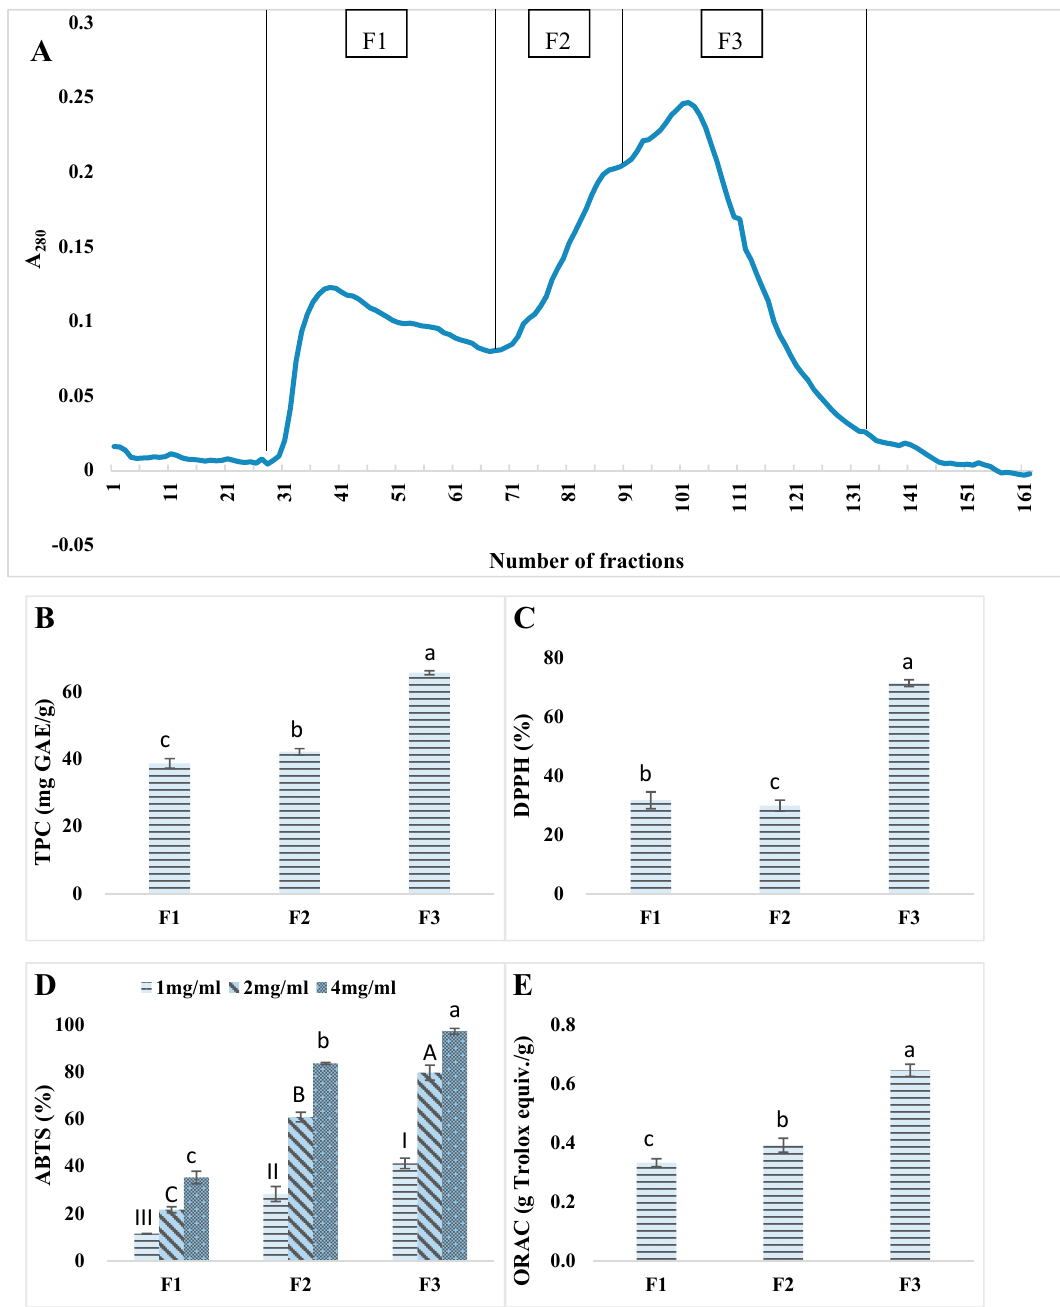
Figure 5. Gel filtration chromatography of kafirin Alcalase 5–10 kDa hydrolysates prepared at enzyme-to-substrate ratio of 0.4 Au/g and hydrolyzed for 4 hr on a Sephadex G-25 column (26 mm × 850 mm). ( A ). Gel filtration chromatogram (Abs at 280 nm); ( B ). Total phenolic content (mg GAE/g); ( C ). DPPH scavenging activity (%) at 5 mg/mL; ( D ). ABTS scavenging activity (%); ( E ). ORAC (g Trolox equivalent/g). Different lowercase and capital letters indicated significant difference at p < 0.05.